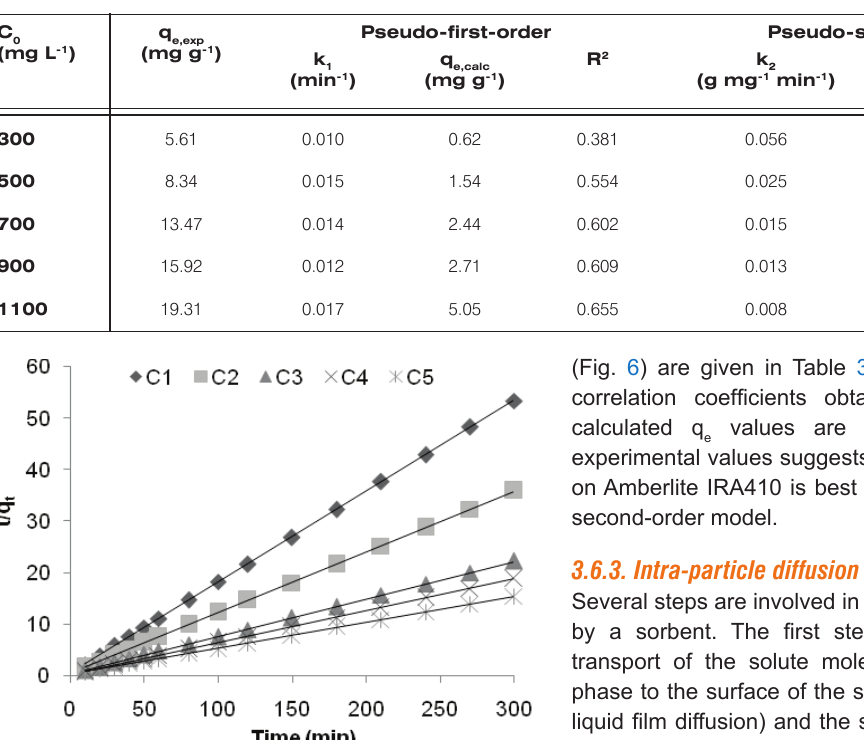
Figure 6. Plot of pseudo-second-order reaction kinetics models for zinc sorption on Amberlite IRA410; C1 = 300 mg L -1